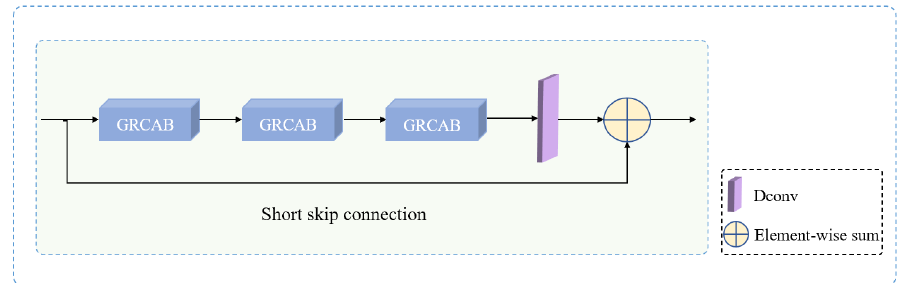
Figure 1. Attention module for improving the remaining channels (GRCAB).